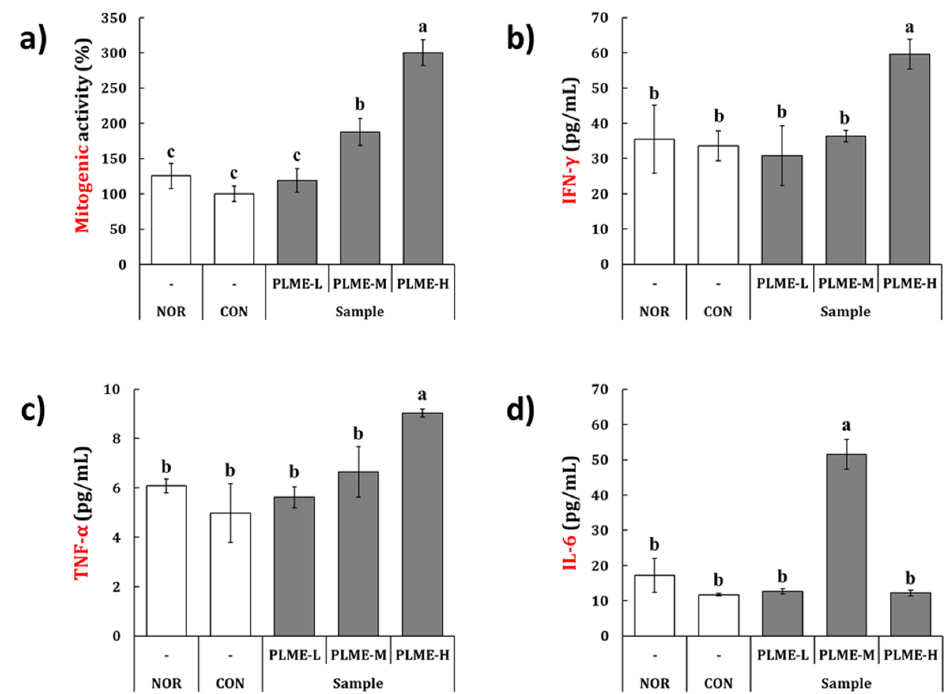
Figure 3. The effect of PLME administration on the ( a ) mitogenic activity and ( b – d ) cytokine production of the splenocytes isolated from mice. The mitogenic activity and levels of cytokines from the splenocytes were determined by WST assay and ELISA, respectively. Different letters indicate a significant difference among groups ( p < 0.05) using Tukey’s multiple range test. NOR, normal group administered tap water; CON, medium control group administered only culture medium (250 mg/kg/day); PLME-L, PLME-M, and PLME-H, sample groups administered postbiotics prepared from P. linteus mycelial submerged culture at doses of 250, 500, and 1000 mg/kg bw/day, respectively.